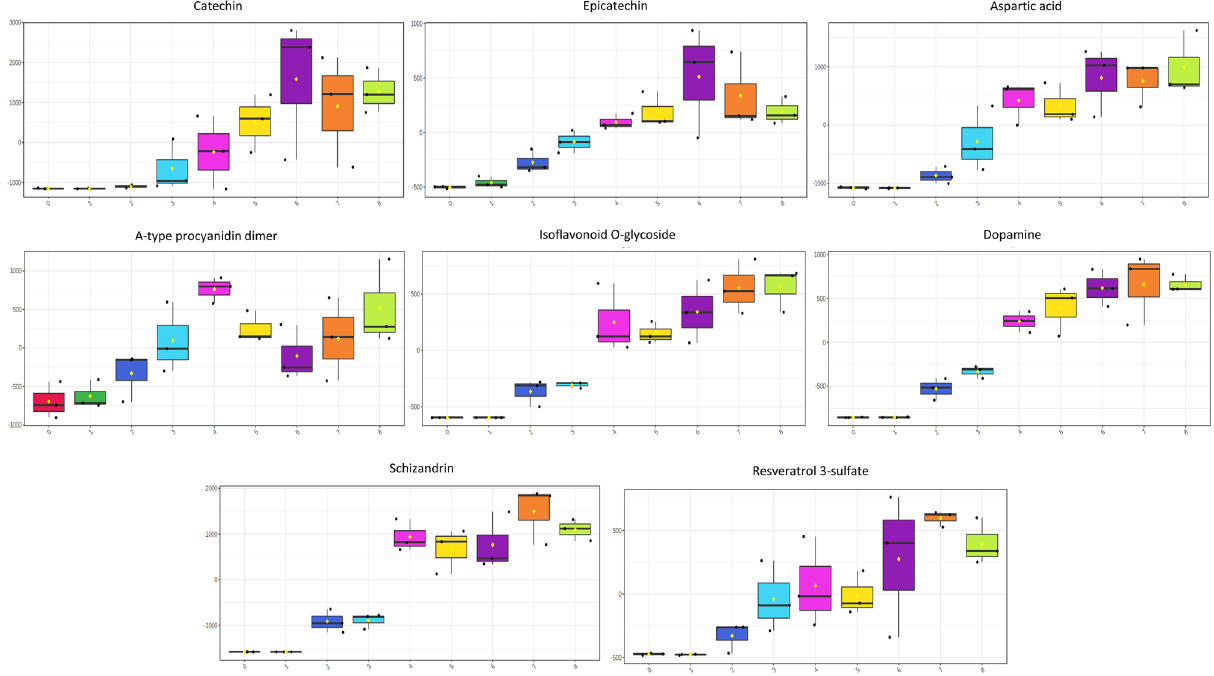
Figure 9. Box plots of bioactive metabolites with significant differences throughout fermentation days (one- way ANOVA correcting for false discovery rate,